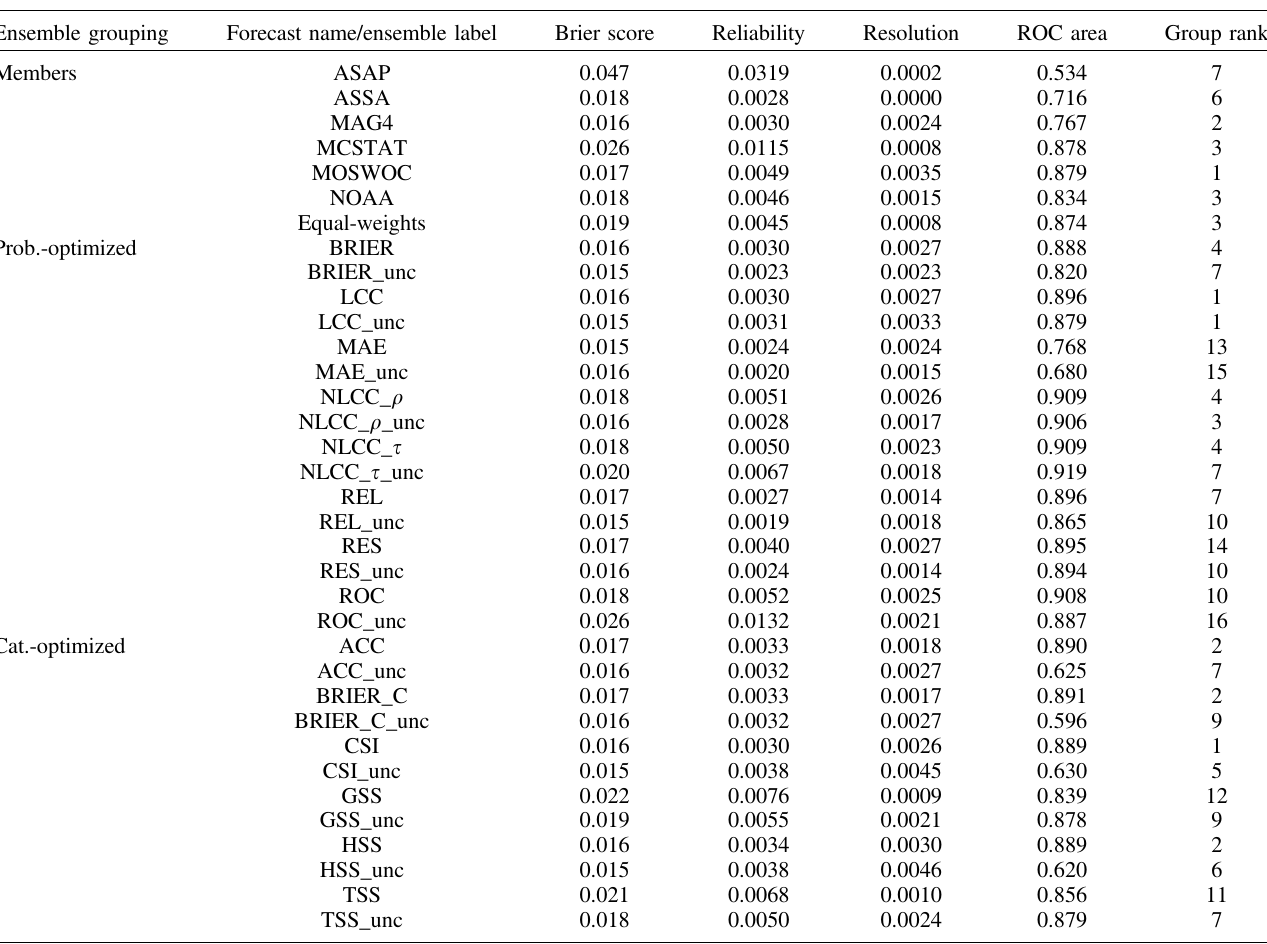
Table B.2. Table with validation metrics for X-class fl are forecasts. Note that there are 17 event days and 1079 non-event days out of 1096 total days, and for all cases the decomposed Brier uncertainty is 0.015.